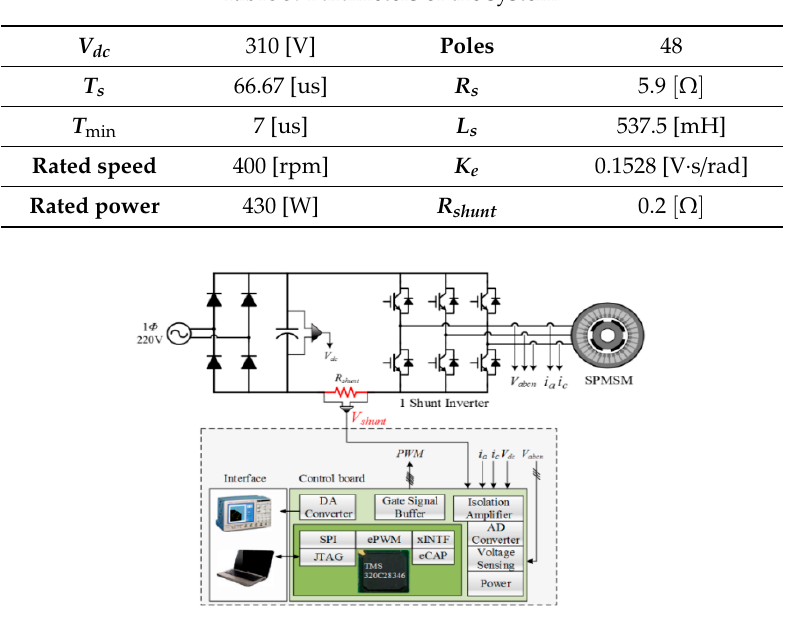
Figure 10. Block diagram of the proposed current reconstruction method in all operation regions.